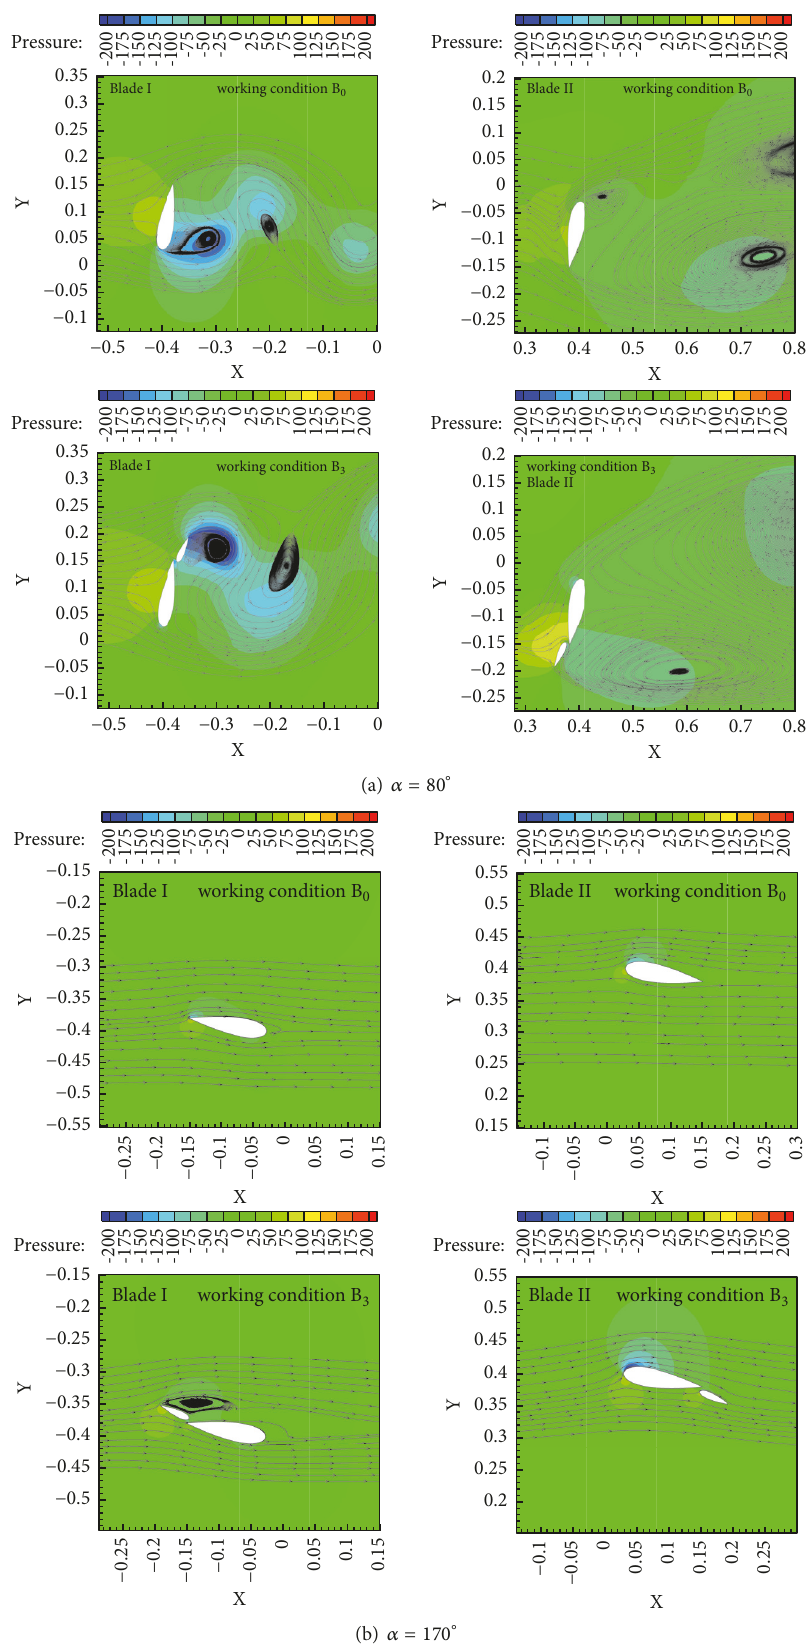
Figure 15: Static flow fields at two azimuth angles of working condition